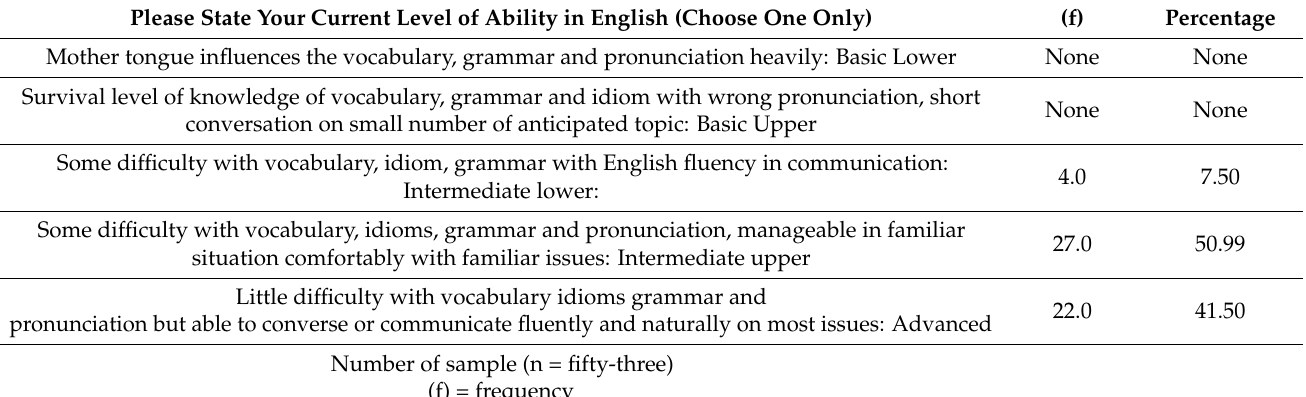
Table 8. Level of Ability in